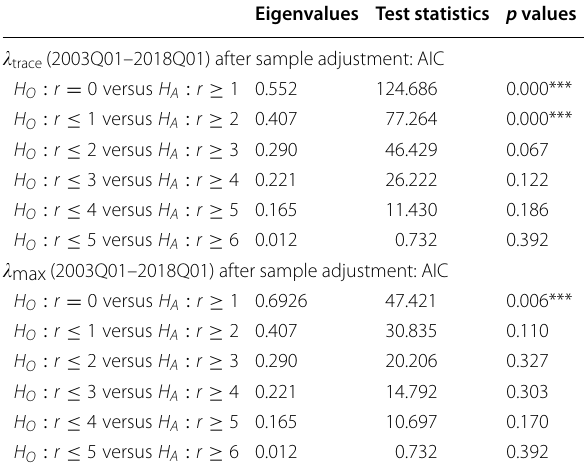
Since government effectiveness (GE) is an I (0) series and shows no linear combination, it is excluded from the test shown in this table ***Significant at 1% level of confidence ( p < 0.01), **Significant at 5% level of confidence ( p < 0.05), *Significant at 10% level of confidence ( p < 0.10) autoregressive model expressed in Eq. (12). Table 6 pre- sents the main results.